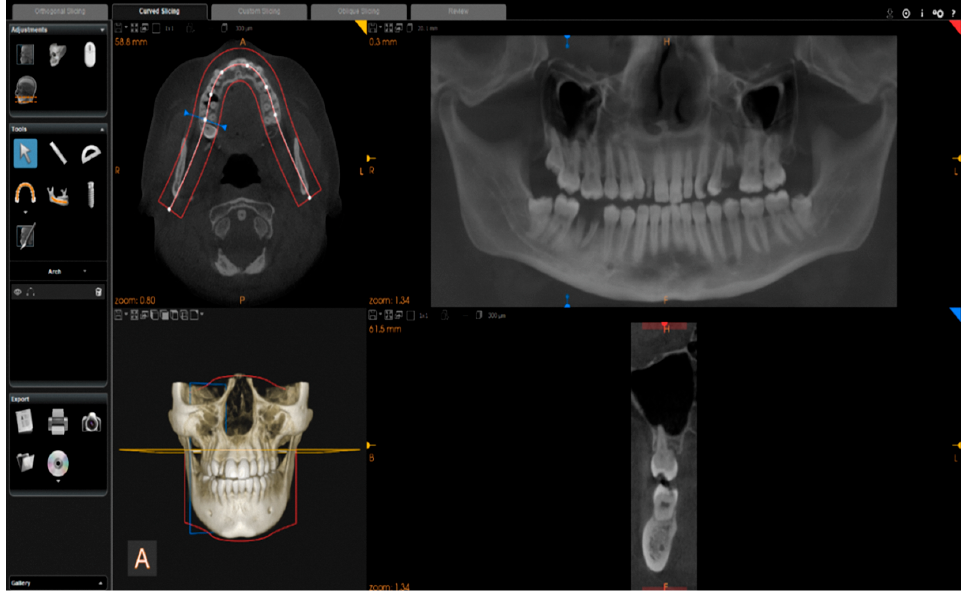
Figure 2. Reconstruction of panoramic images from CBCT volumes.